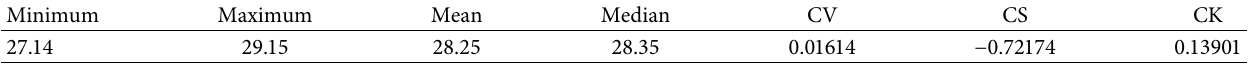
Table 6: Descriptive statistics of annual maximum